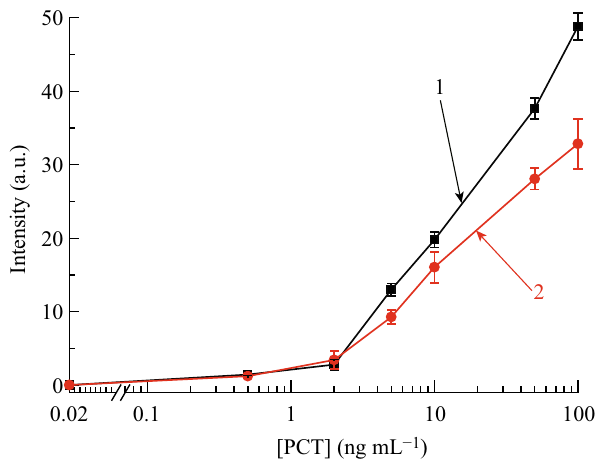
Fig. 4 Calibration curves of PCT LFIA for different combinations of antibodies: (1) immobilized antibodies–mAb, detection antibodies– pAb, and (2) immobilized antibodies–pAb, detection antibodies–mAb